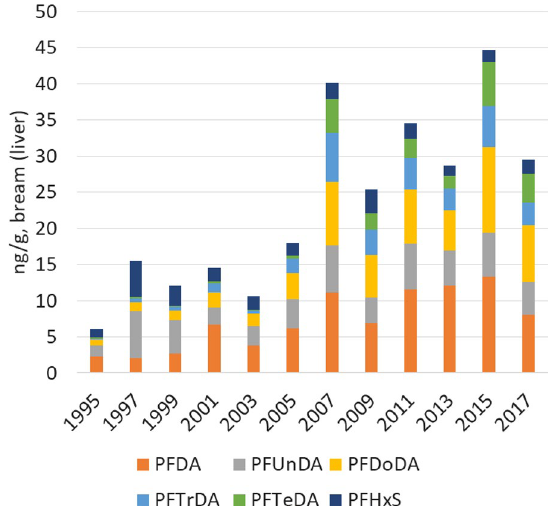
Fig. 1 Increase in concentration of longer-chain perfluorocarboxylic acids in the liver of bream at Bimmen (Lower Rhine) © Environmental Specimen Bank [112]